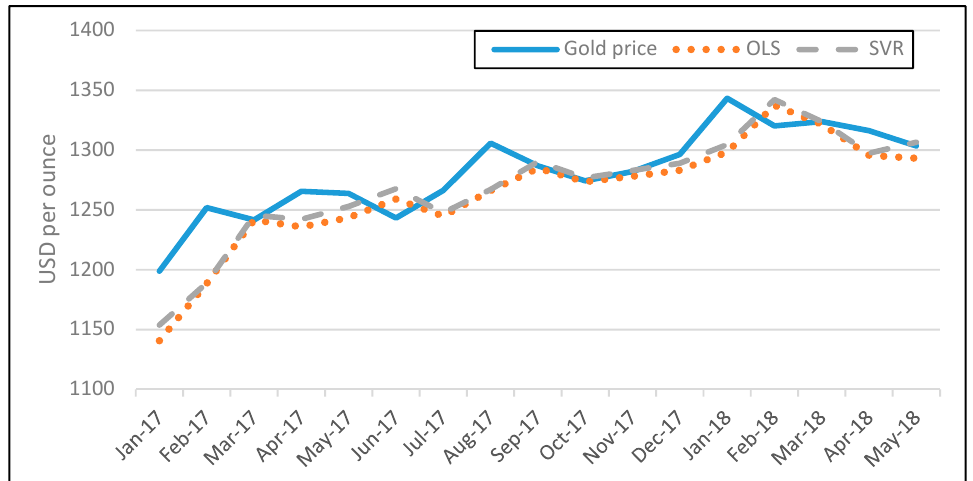
Figure 8. Out-of-sample one-month ahead gold prices forecasts for China based on the GPR index for the SVR and OLS model for the period Jan-2017 to May-2018.